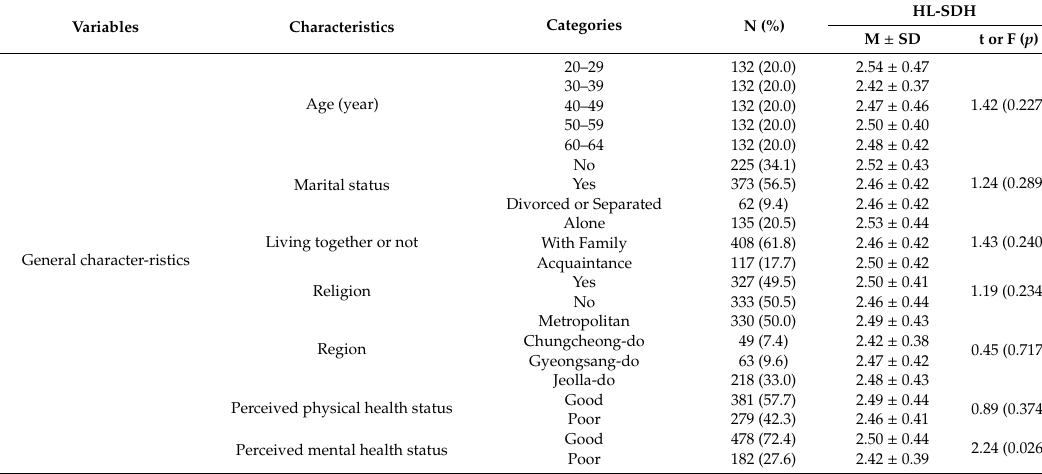
Table 1. Di ff erence in HL-SDH by general characteristics ( N = 660).